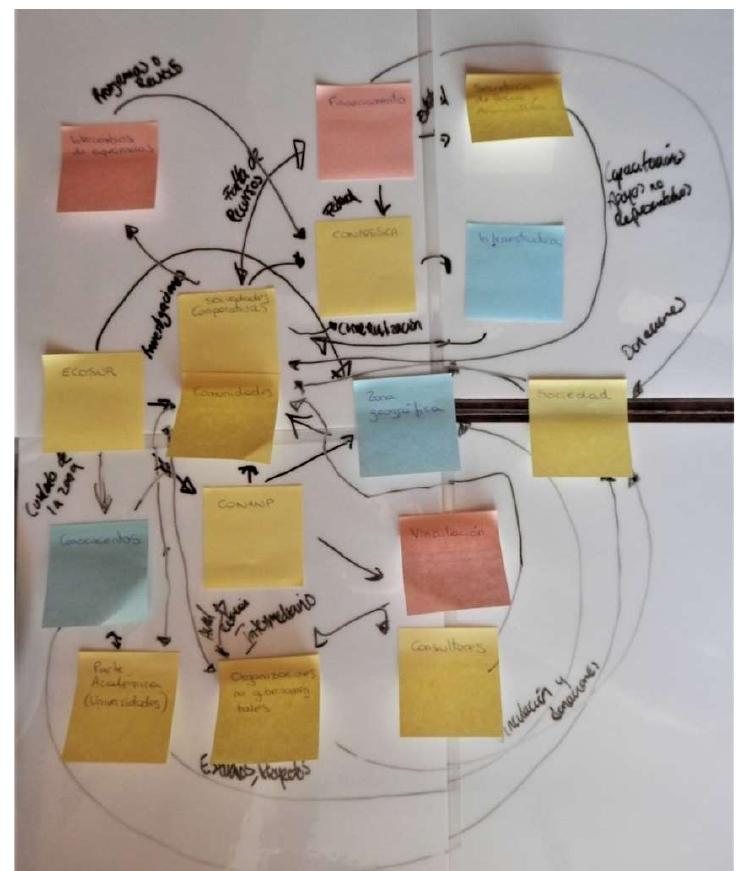
Fig. A1.2. Diagrammatic representation of a mental